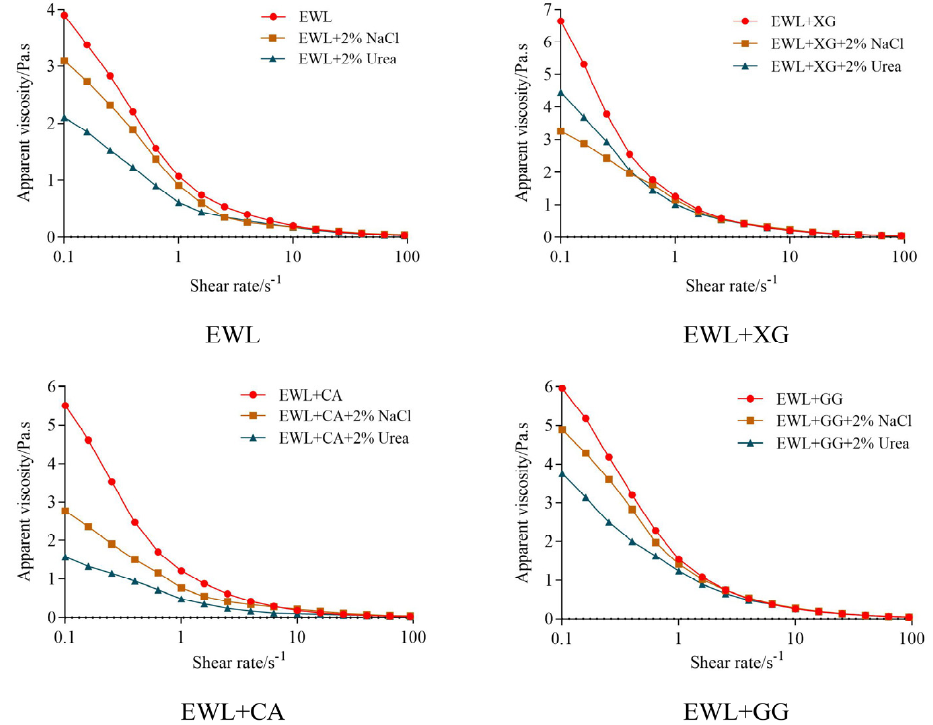
Figure 6. Electrostatic interaction and hydrogen bonding between polysaccharides and egg white protein.